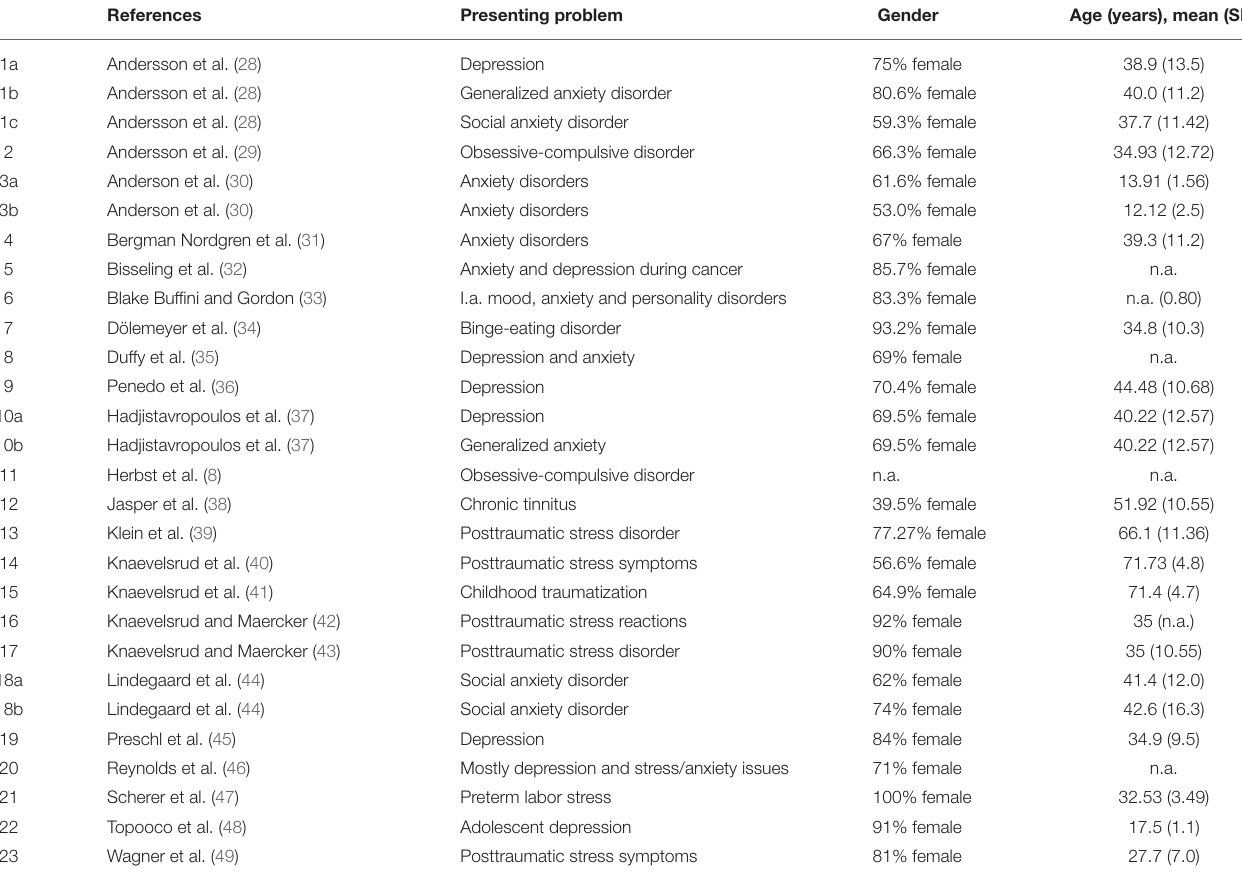
TABLE 1 | Participant